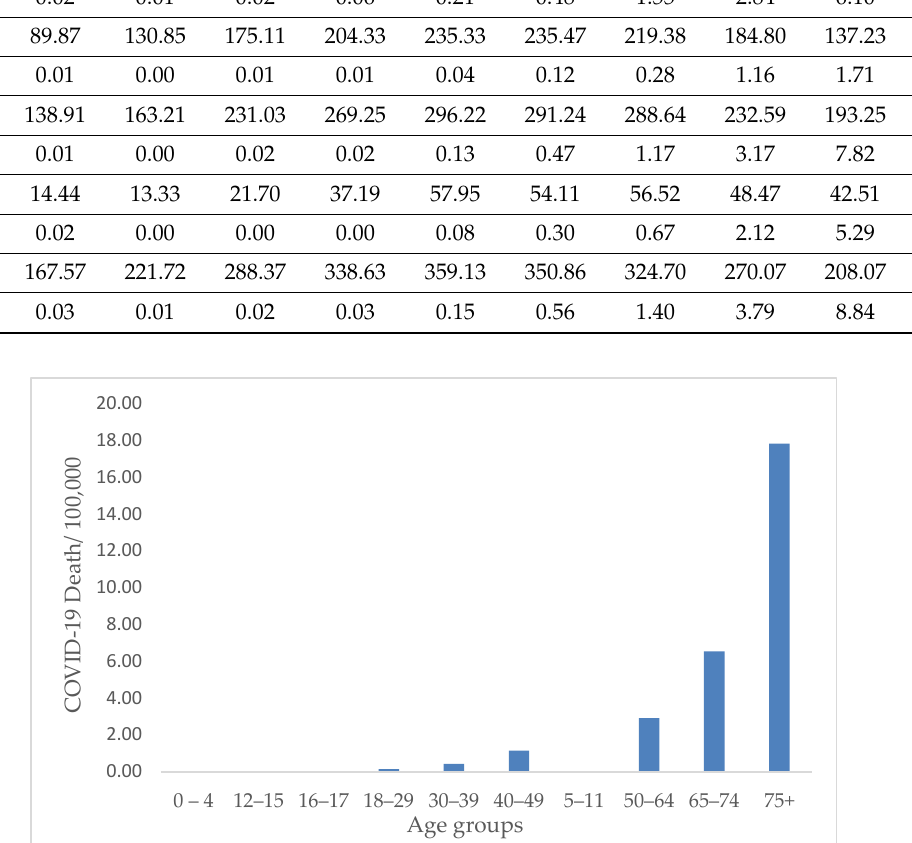
Figure 7. Average COVID-19 death rate by age group in all states from 2020 to 2022. The highest death rate was observed in the elderly population above the age of 75 years in the selected